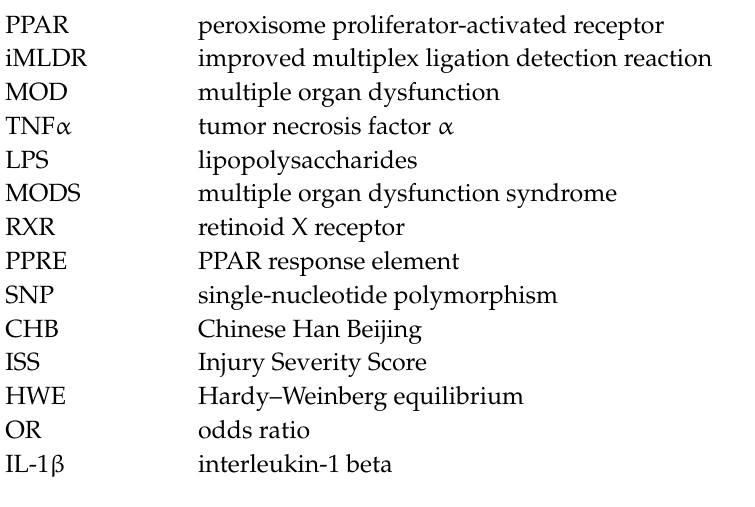
Figure S2: Linkage disequilibrium (LD) plot of the SNPs with a MAF ě 5% within the PPAR β gene and 3 kb up- and down-stream regions are displayed using an r 2 black and white color scheme. Black represents very high LD (r 2 = 1), and white indicates the absence of correlation (r 2 = 0) between SNPs. The selected SNPs and SNPs that are indirectly measured by them are listed with corresponding r 2 values. The alleles of selected SNPs are given with their frequencies, according to the HapMap data for Chinese individuals from Beijing, Figure S3: Linkage disequilibrium (LD) plot of the SNPs with a MAF ě 5% within the PPAR γ gene and 3 kb up- and down-stream regions are displayed using an r 2 black and white color scheme. Black represents very high LD (r 2 = 1), and white indicates the absence of correlation (r 2 = 0) between SNPs. The selected SNPs and SNPs that are indirectly measured by them are listed with corresponding r 2 values. The alleles of selected SNPs are given with their frequencies, according to the HapMap data for Chinese individuals from Beijing, Table S1: The total SNPs identified from the 137 healthy Chinese Han Beijing (CHB) individuals of the HapMap project, Table S2: The total common SNPs with a MAF ě 5% identified from the 137 healthy Chinese Han Beijing (CHB) individuals of the HapMap